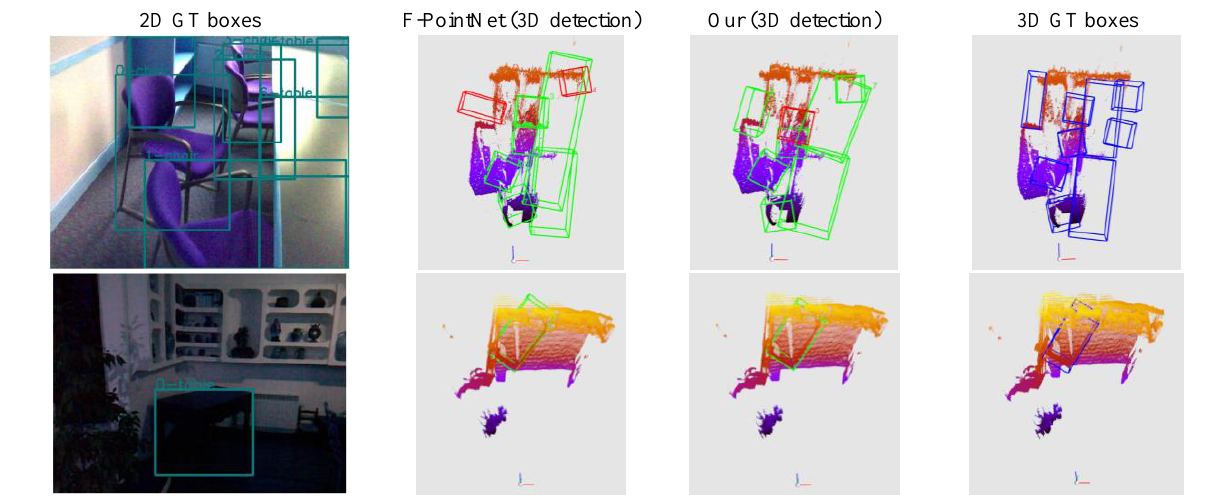
Figure 4. Visualization of results on SUN-RGBD val set. show the performance of our architecture for small object detection and strong occlusion of object detection. Fig. 4 visualizes the results on SUN-RGBD val set. First column: 2D ground true bounding boxes. Second column: the predicted 3D bounding boxes results from F-PointNet. Third column: our method detection results and predicted 3D bounding boxes. Fourth column: 3D ground true bounding boxes. Green boxes are true positive and red boxes are false positives. Compared to F-PointNet, we can find that our algorithm has the success detection of the bookshelf and has higher accuracy segmentation ability for the table (successful separate two close tables). The second example shows our method have more fine-grained segmentation results (our method has a more accurate box size that F-PointNet).